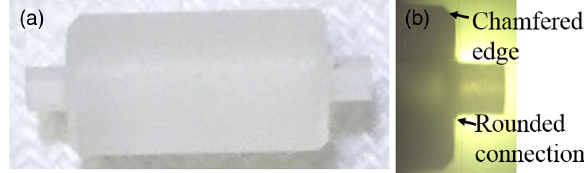
FIG. 13. (a) The rolling-pin sapphire rod made by Gavish, Inc., and (b) a comparator image showing the rounded connection and the chamfered edge.